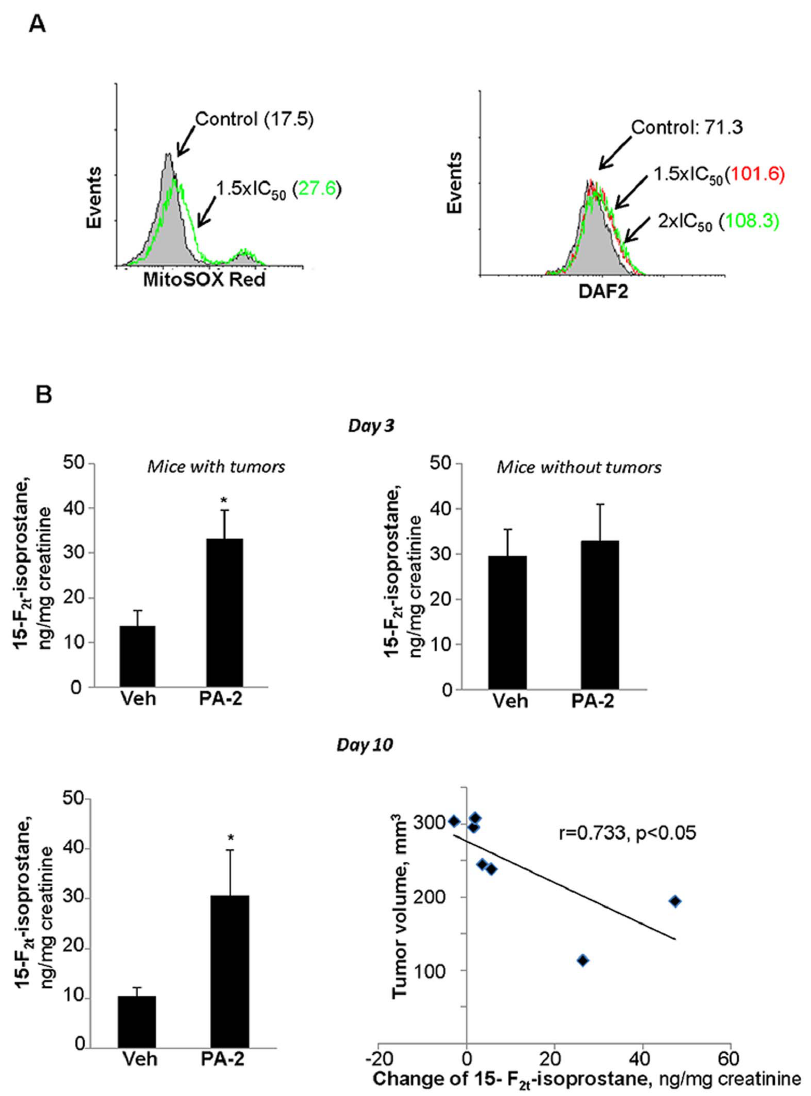
Figure 6. Phospho-aspirin-2 induces oxidative stress. A: Left : Mitochondria superoxide was measured by MitoSOX Red dye after treatment of MCF7 cells with PA-2. Right : Nitric oxide levels was determined by DAF2 staining after treatment with PA-2. B: The levels of 15-F 2t -isoprostane in 24-h urine of nude mice were determined using an enzyme-linked immunosorbent assay kit. Left : results from nude mice bearing MCF7 xenografts on day 3 (top) and day 10 (bottom). Right : results from nude mice bearing no xenografts on day 3 (top). The association between tumor volume and urinary 15-F 2t -isoprostane levels in the nude mice from the xenograft study is shown (bottom).